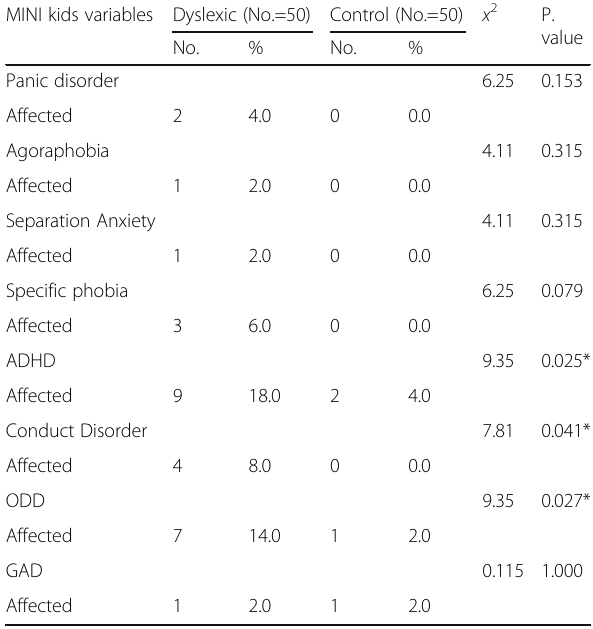
Table 2 Frequency distribution of different psychiatric disorders among dyslexic and control groups according to Mini Kid